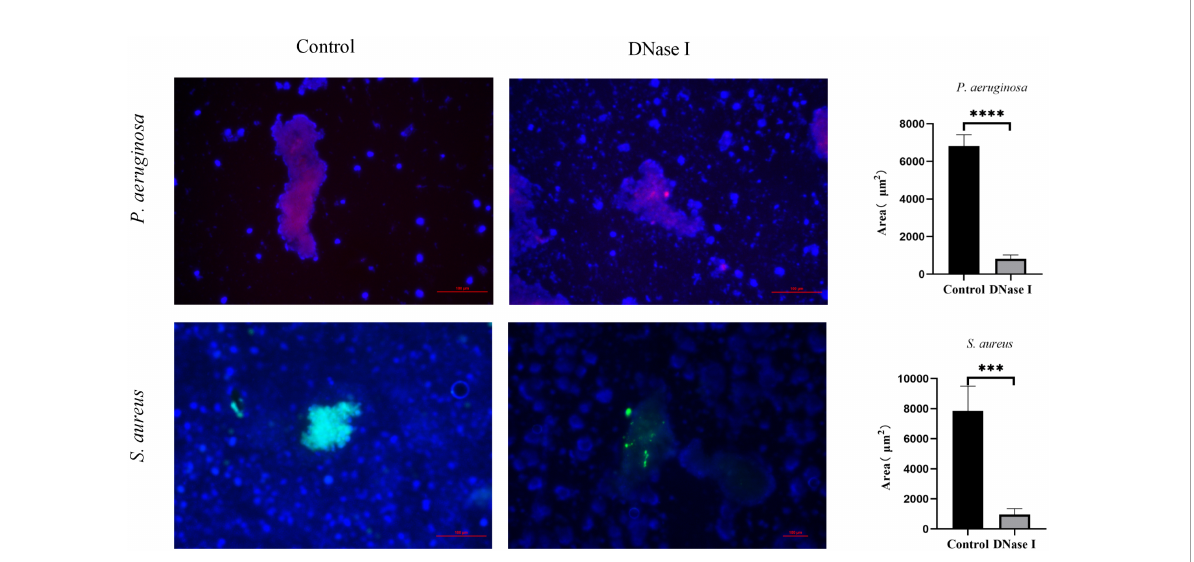
FIGURE 11 PNA-FISH of fi brinous depositions in purulent exudates (100×). The PNA-FISH kit contained a P. aeruginosa -speci fi c probe (red), an S. aureus - speci fi c probe (green), and an unspeci fi c nucleic acid stain DAPI (blue) to show the bio fi lms. The fi gure shows that the mass bacteria in the control rabbits were surrounded by host cells. The red and yellow portions are the bacterial aggregates surrounded by polymorphonuclear leukocytes. In the DNase I-treated rabbits, few bacteria were surrounded by host cells. We determined the bio fi lm sizes using PNA-FISH. The results are presented as mean ± SD. An asterisk indicates a signi fi cant difference; *** indicates p < 0.001 and **** indicates p < 0.0001, compared with the values in the drug-free control group using t -tests (n =